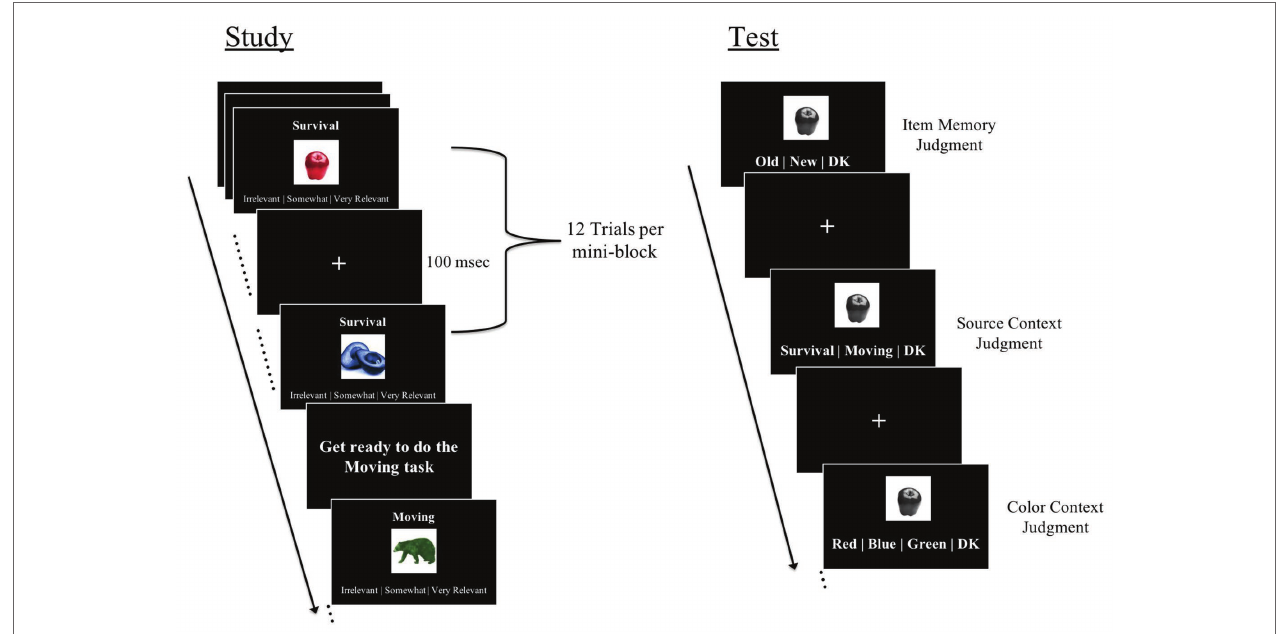
FIGURE 1 | Trial schematic for several study phase trials and a single test phase